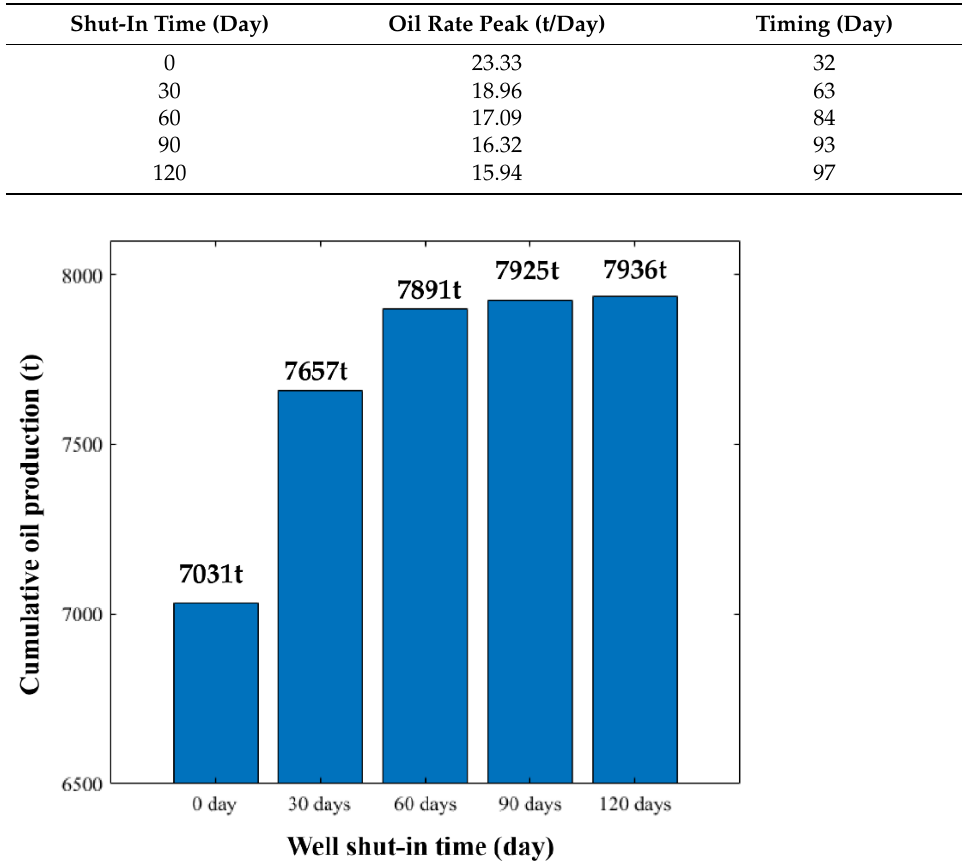
Table 4. Peak production rate and their timings according to five simulation scenarios.